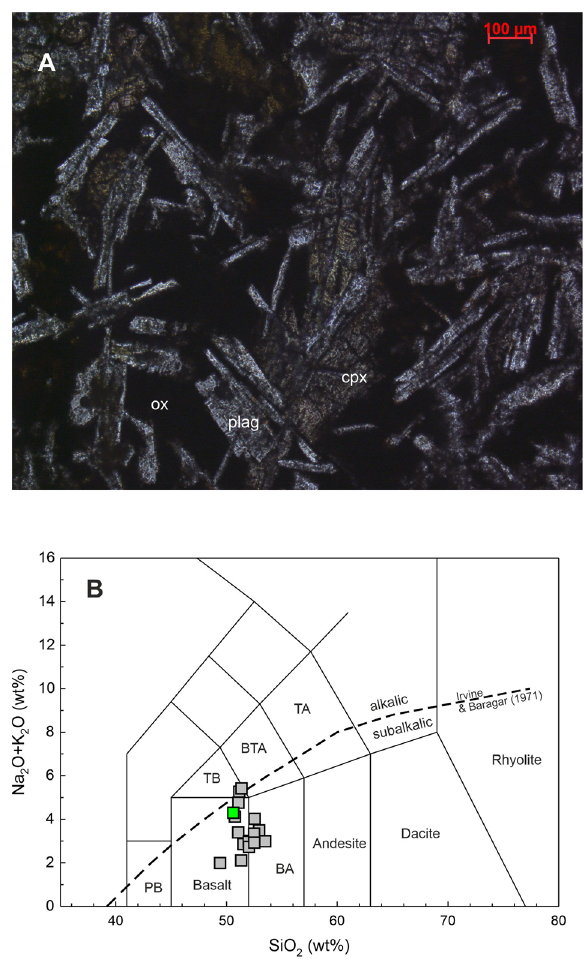
Figure 5. ( A ) Photomicrograph of a thin section of the sample chip from the Chilika Anchor showing plagioclase laths (plag), clino pyroxene (cpx) and dark iron oxides (ox). The texture seen is typical of a basaltic lava; ( B ) Anchor basalt datum (green square) plotted on a total alkali silica (TAS) diagram (Le Bas et al., 1986) 14 . The Boundary line between the alkalic and subalkalic field is by Irvine and Baragar (1971) 15 . Also plotted are data for lava flows of Palitana, Gujarat, India (data source: Sheth et al., 2013) 16